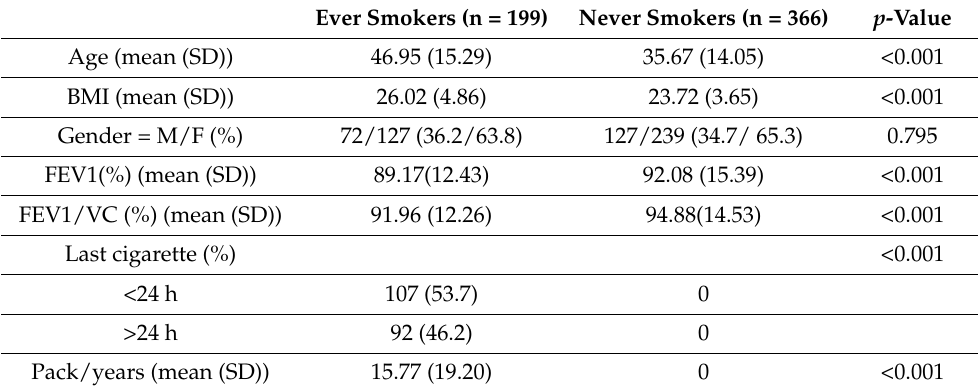
Table 3. Demographics of healthy subjects stratified by smoking status. Data are expressed in number of patients, mean ± standard